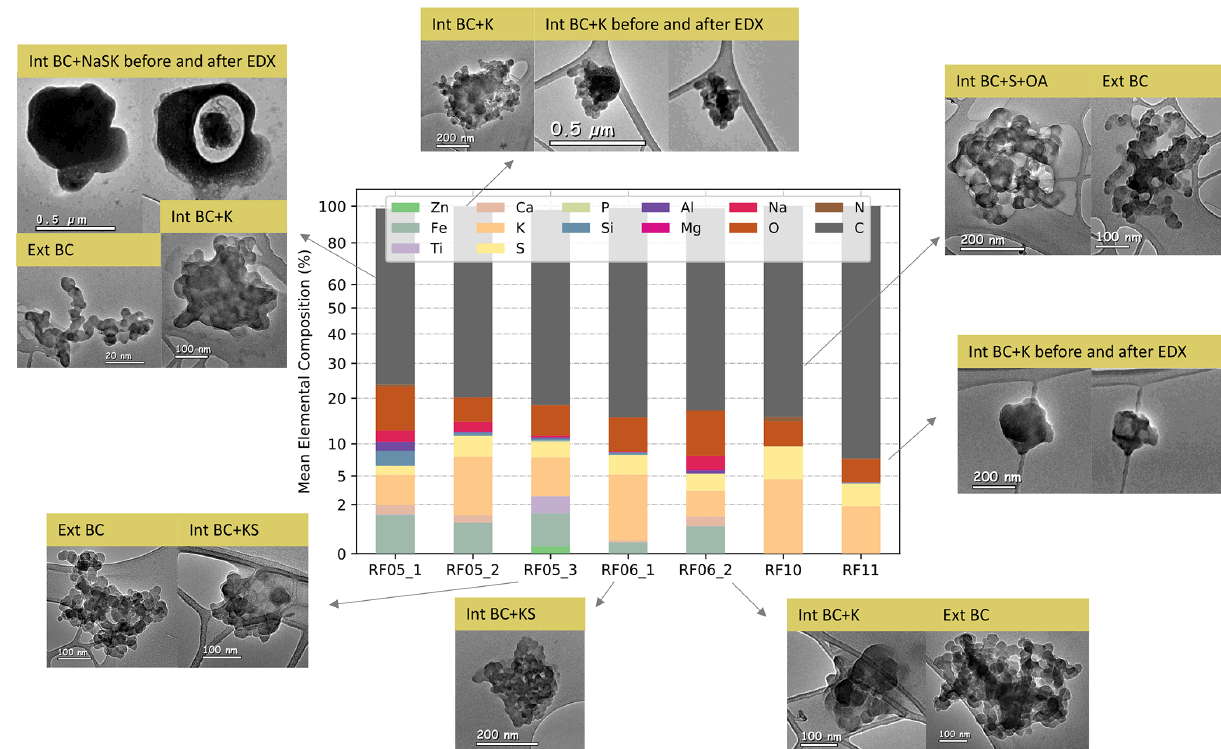
Figure 5. Elemental composition and representative microphysical images of different types of BC-containing particles from TEM analysis for each flight. Int BC and Ext BC represent internally and externally mixed BC particles, respectively. For example, Int BC + K stands for internally mixed BC with potassium salts. The y axis uses a x 1 / 2